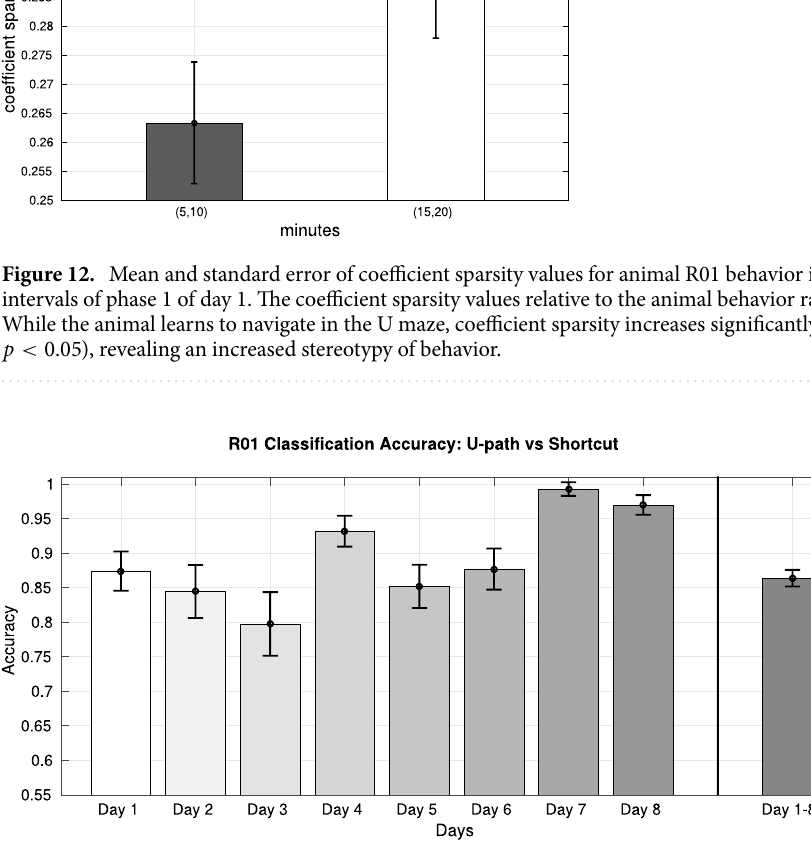
Figure 13. Classification of trajectories (U-path or shortcut) of phase 3, animal